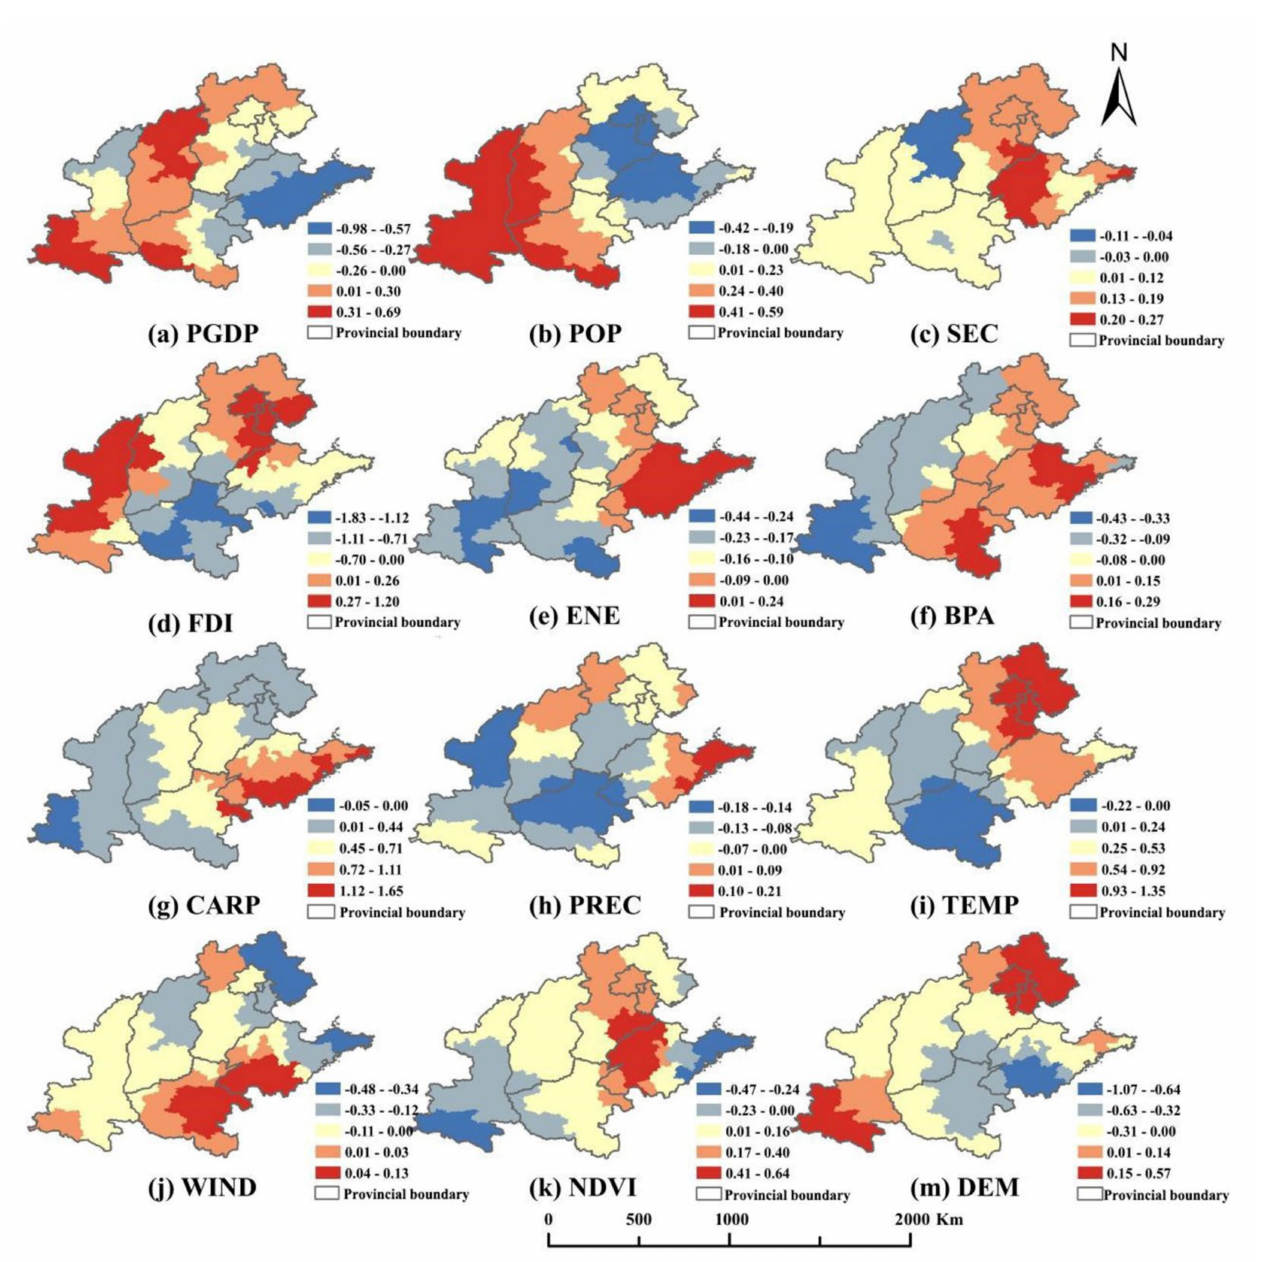
Figure 9. Spatial distribution of regression coefficients of influencing factors in the GTWR